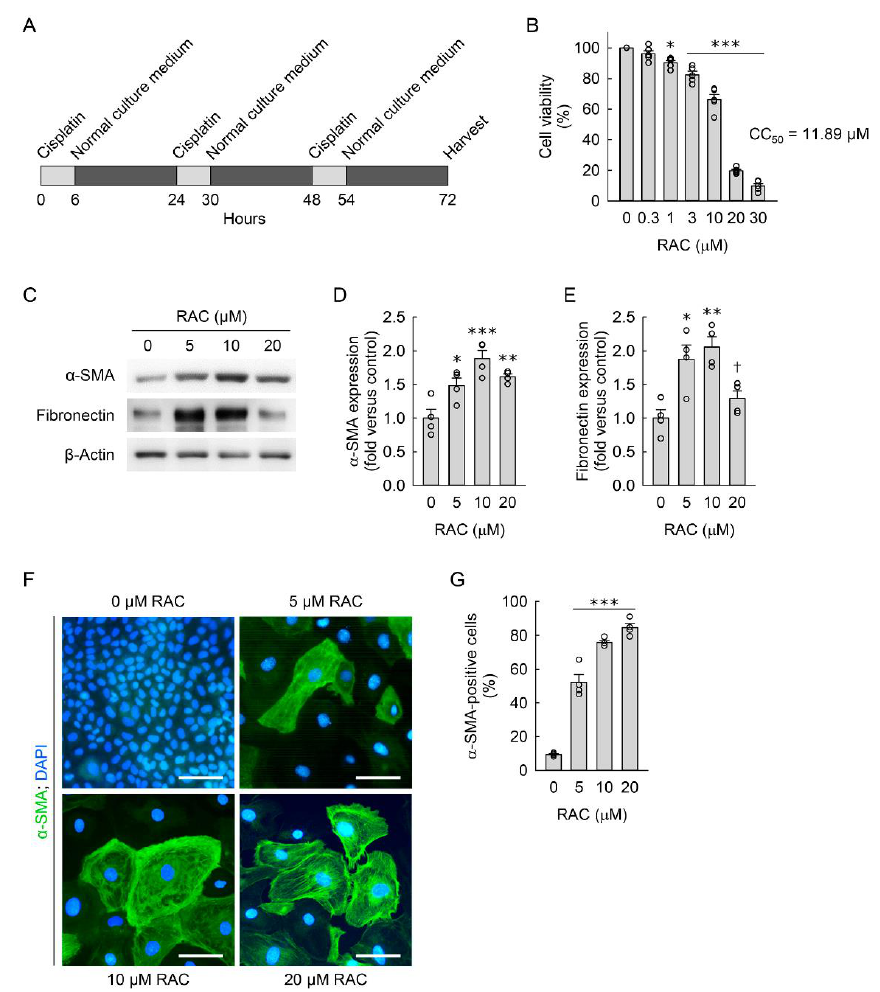
compared to untreated cells, RAC significantly enlarged cell volume (Figure 2D,E). These data indicate that RAC induces cellular hypertrophy in resident kidney fibroblast cells.